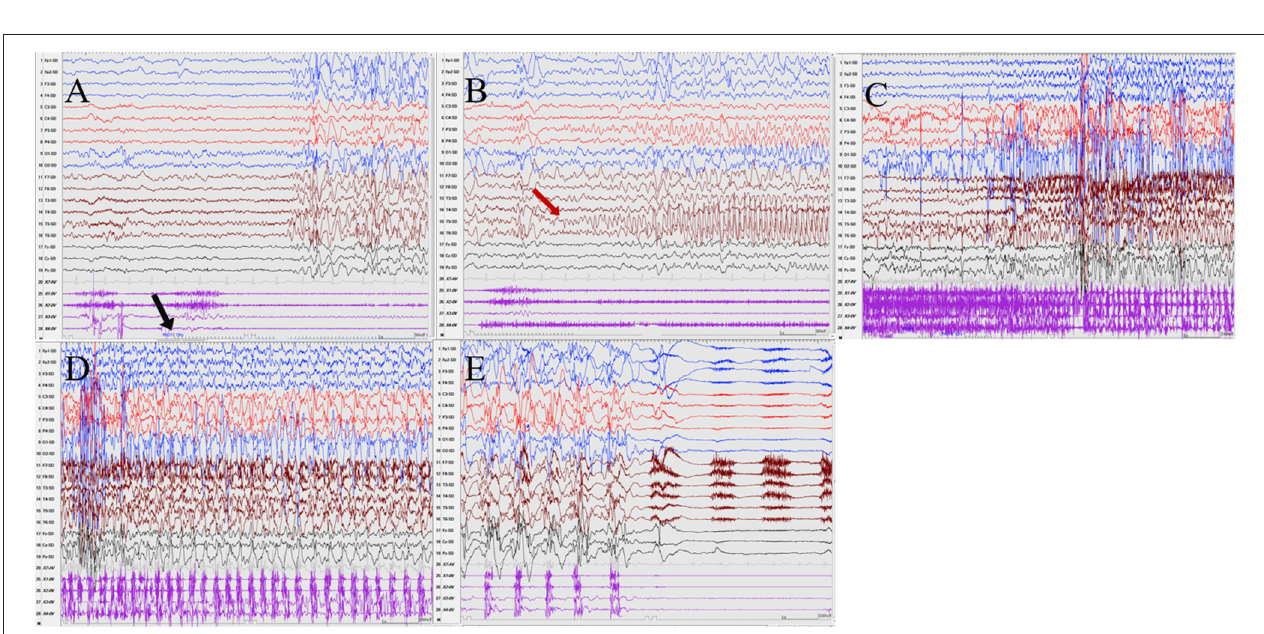
FIGURE 2 | The ictal EEG of left temporal onset focal seizure induced by IPS in patient 1 (A – E) the initial 1.5–2-Hz slow waves in the left anterior and mesial temporal area → the spikes mixed waves, and then medium amplitude delta waves in the left temporal area. (The red arrow represents the origin of the seizure; the black arrow represents the starting point of the IPS.) (EEG, electrocardiogram; IPS, intermittent photic stimulation; X1, left deltoid; X2, right deltoid).